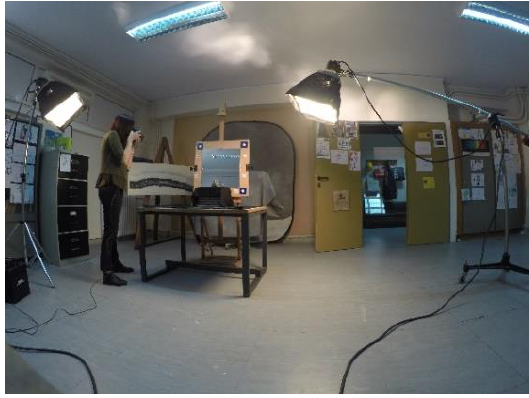
Figure 13: Image-based modelling experiment setup